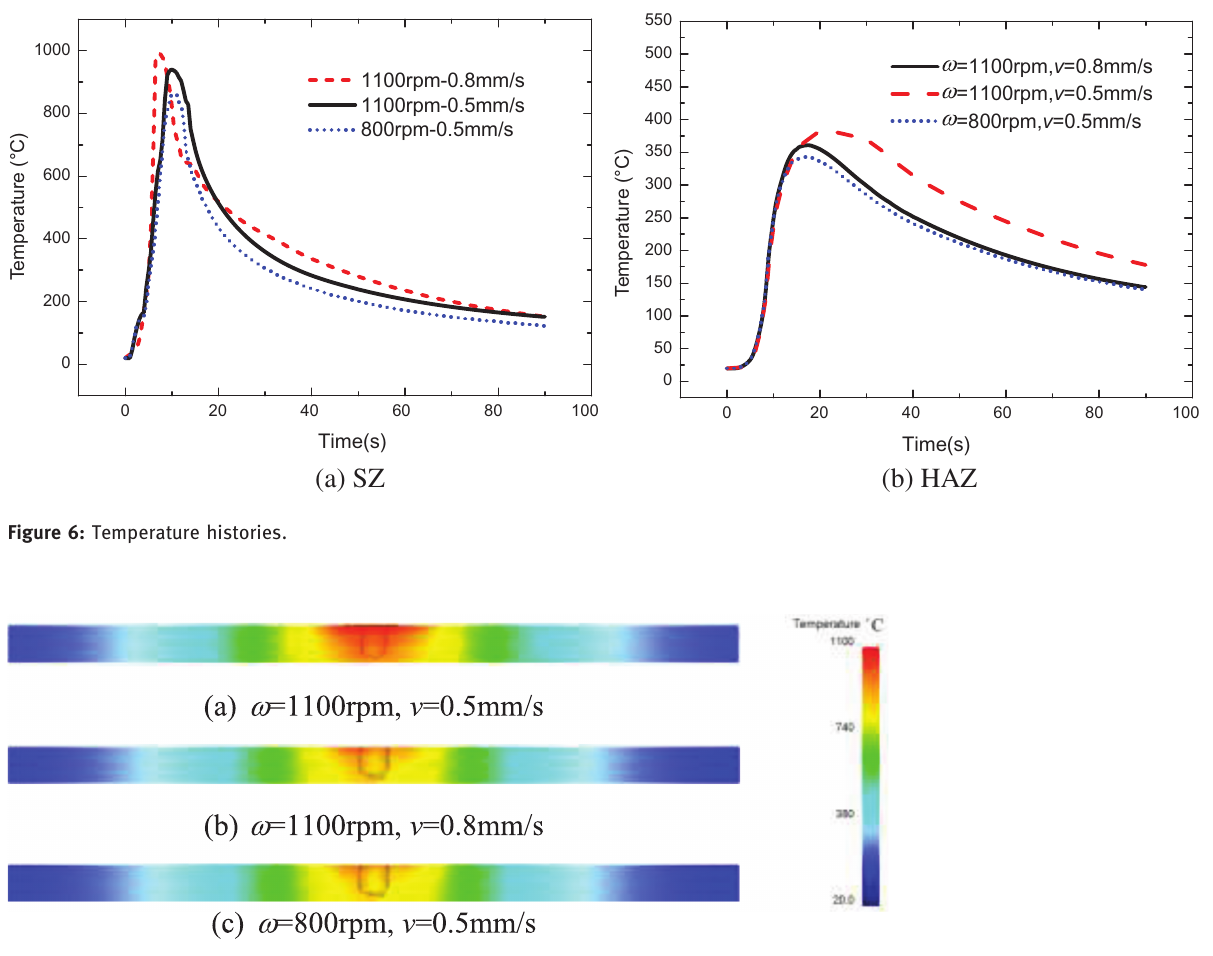
Figure 7: Temperature distribution during the weld in different cases.